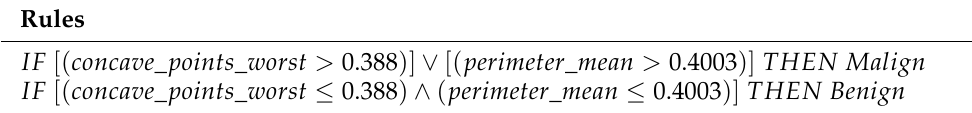
Table A8. Final rule set, for the BCWD dataset generated by DEXiRE. Rules